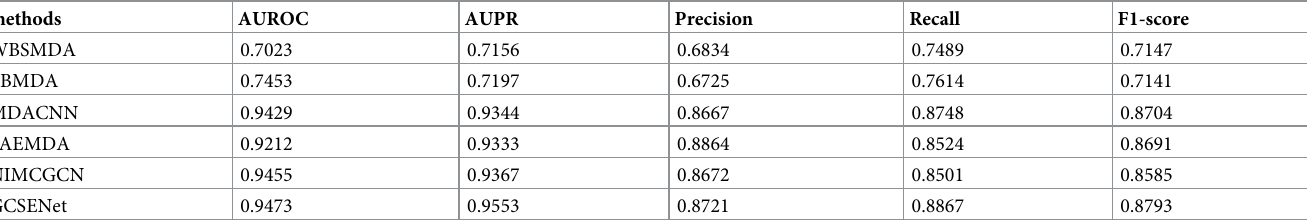
Table 3. Performance comparison with various methods for miRNA-phenotype association prediction. methods